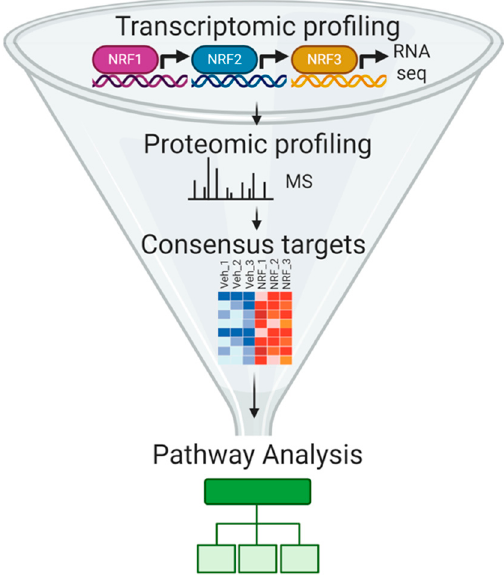
Figure 2. Schematic depicting the strategy used in this work to define the functional targets of the NRF transcription factors.